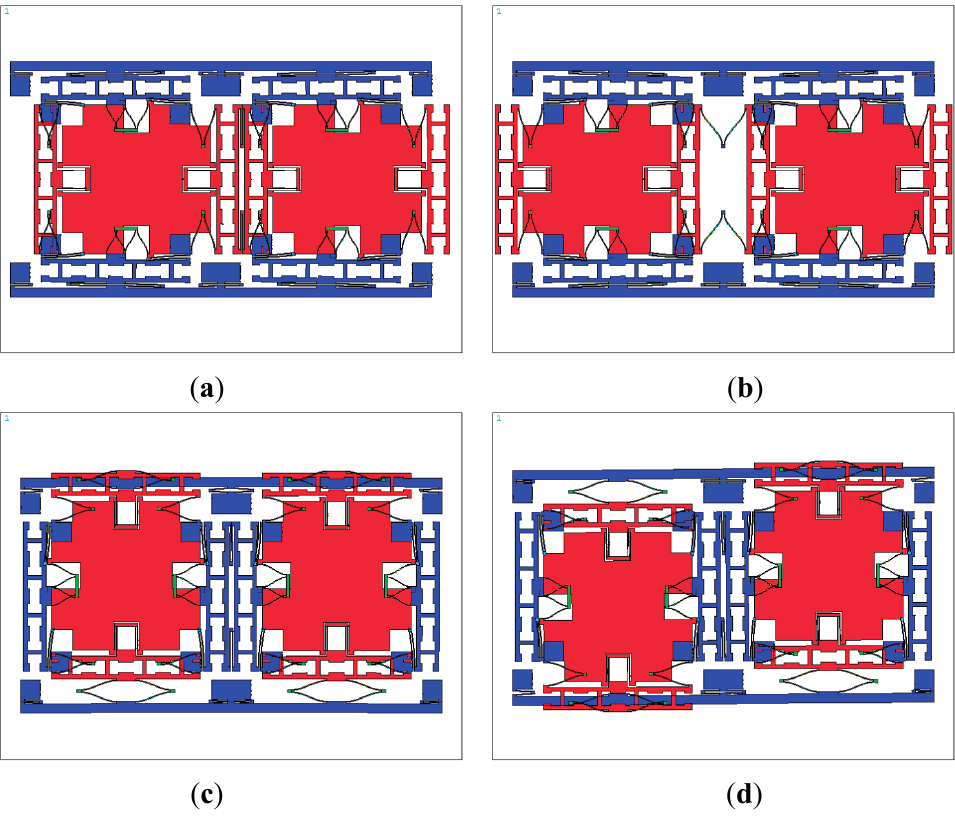
Figure 8. Fabrication process of Deep Dry Silicon On Glass